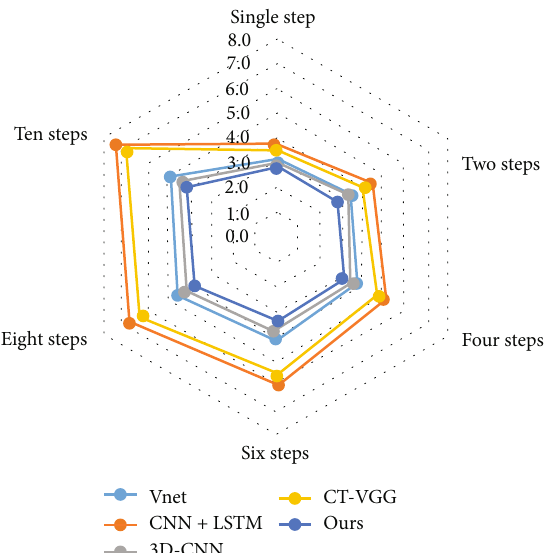
Figure 10: Comparison of running time of di ff erent